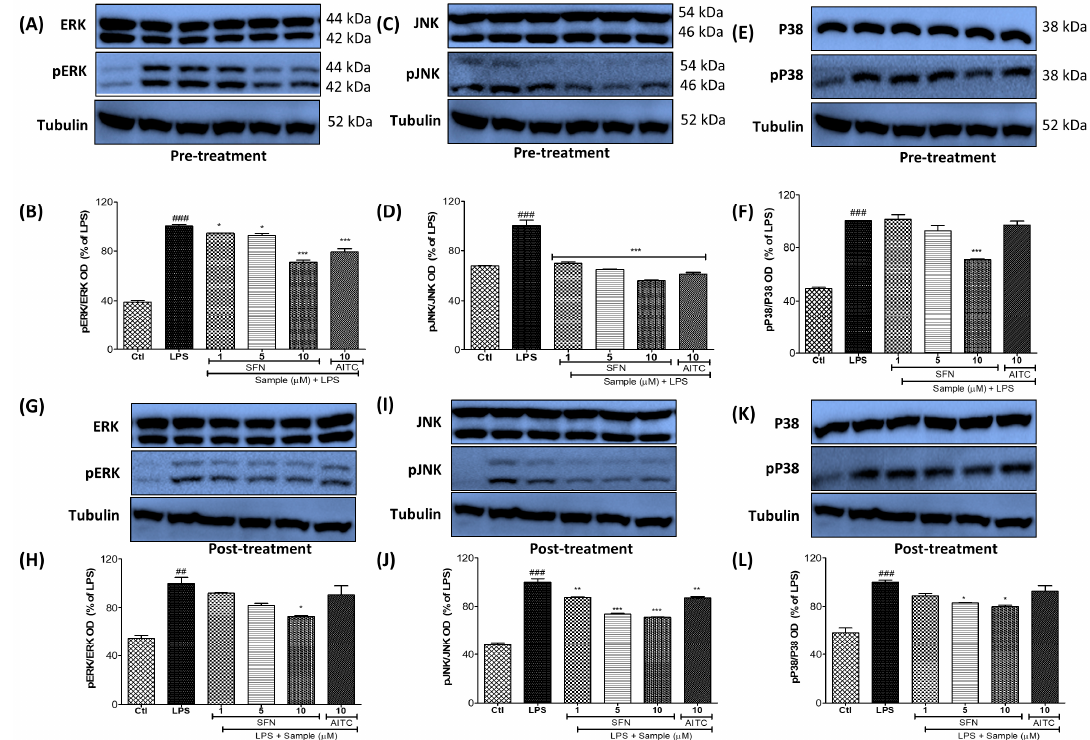
Figure 4. SFN modulated MAPK effector signaling after 30 min of pre-treatment (Sample ( µ M) + LPS) or post-treatment (LPS + Sample ( µ M)) in BV2 microglial cells. The cells were activated with LPS (100 ng/mL) at 30 min before/after the chemical treatments. Chemical samples of different concentrations were added in each condition. The LPS incubation was performed for 30 min. ( A – F ) Protein expression and band intensity of pERK/ERK, pJNK/JNK, and p-p38/p38 in LPS-activated microglia. α -Tubulin was used as a loading control. All data are presented as the mean ± standard error of the mean of three independent experiments. * p < 0.05, ** p < 0.01, and *** p < 0.001 indicate significant differences compared with LPS treatment alone; ## p < 0.01 and ### p < 0.001 indicate significant differences compared with the untreated control group. Ctl—untreated control cells; LPS—cells treated with lipopolysaccharide only.